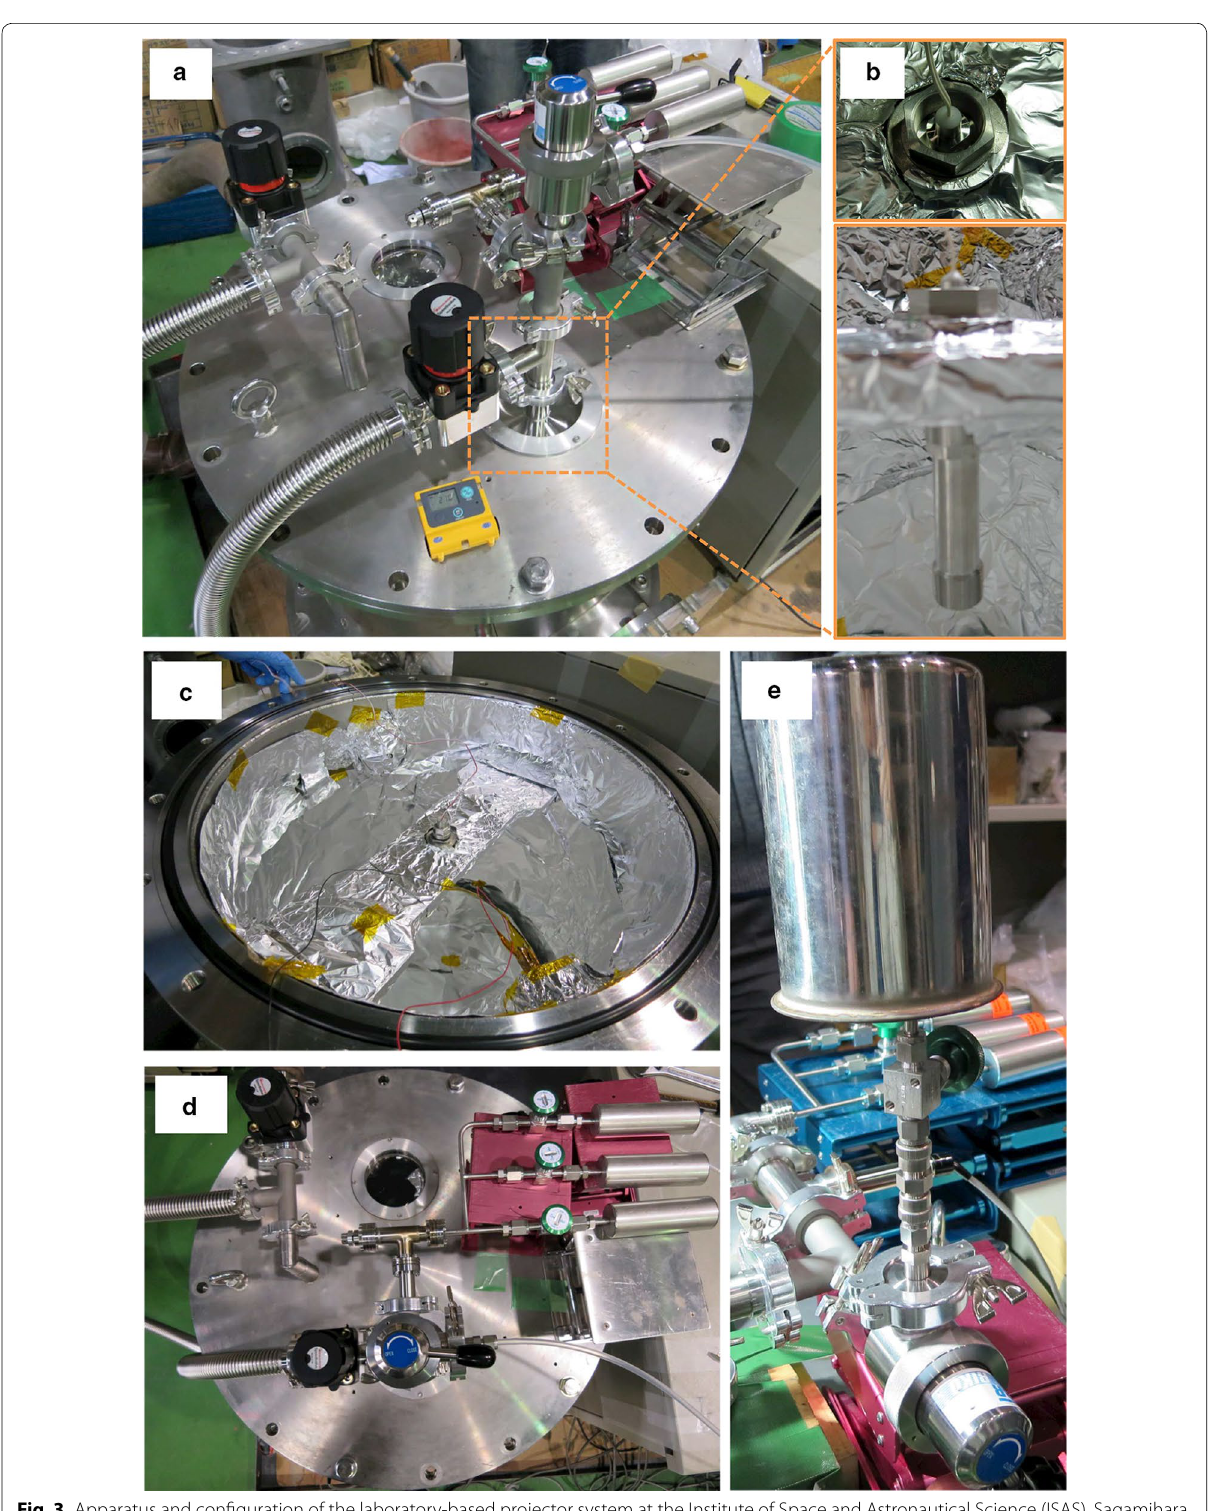
Fig. 3 Apparatus and configuration of the laboratory-based projector system at the Institute of Space and Astronautical Science (ISAS), Sagamihara, in March 2015; a upper part of the projectile chamber, b explosive chamber, c interior of the projectile chamber, d , e gas sample cylinders, and f schematic diagram of the entire simulation. The anomalous element profiles of metal (e.g., Aluminum) derived from the explosive chamber are potential indicators to trace the artifact if the sample has affected by off-nominal projectile